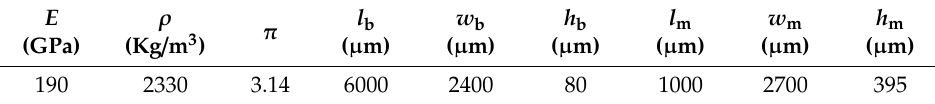
Table 1. Theoretical calculation parameters of resonance frequency.